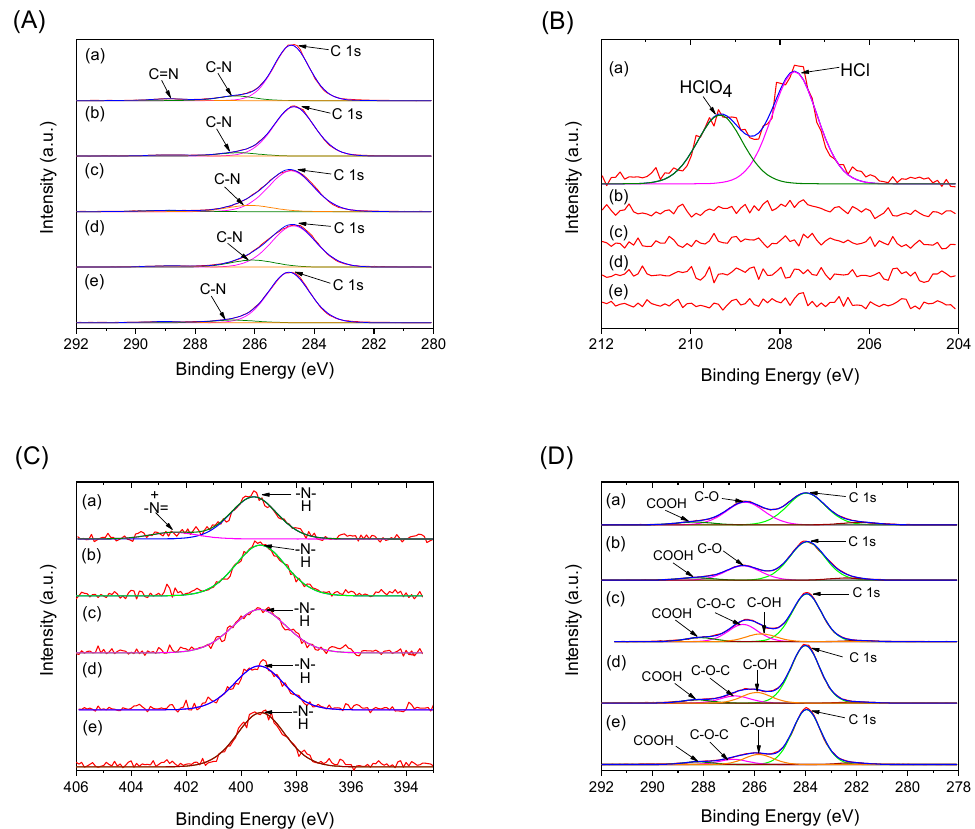
Figure 3. High-resolution X-ray photoelectron spectrometer (XPS) spectra of C 1s ( A ), Cl 1s ( B ) and N 1s ( C ) of as-synthesized PEANI / GO (a) and PEANI / rGO obtained by reduction with hydrazine of 70 µ L (b), 140 µ L (c), 420 µ L (d), and 1400 µ L (e); high-resolution XPS spectra of C 1s ( D ) of pure GO (a) and rGO obtained by reduction with hydrazine of 25 µ L (b), 50 µ L (c), 150 µ L (d), and 400 µ L (e).